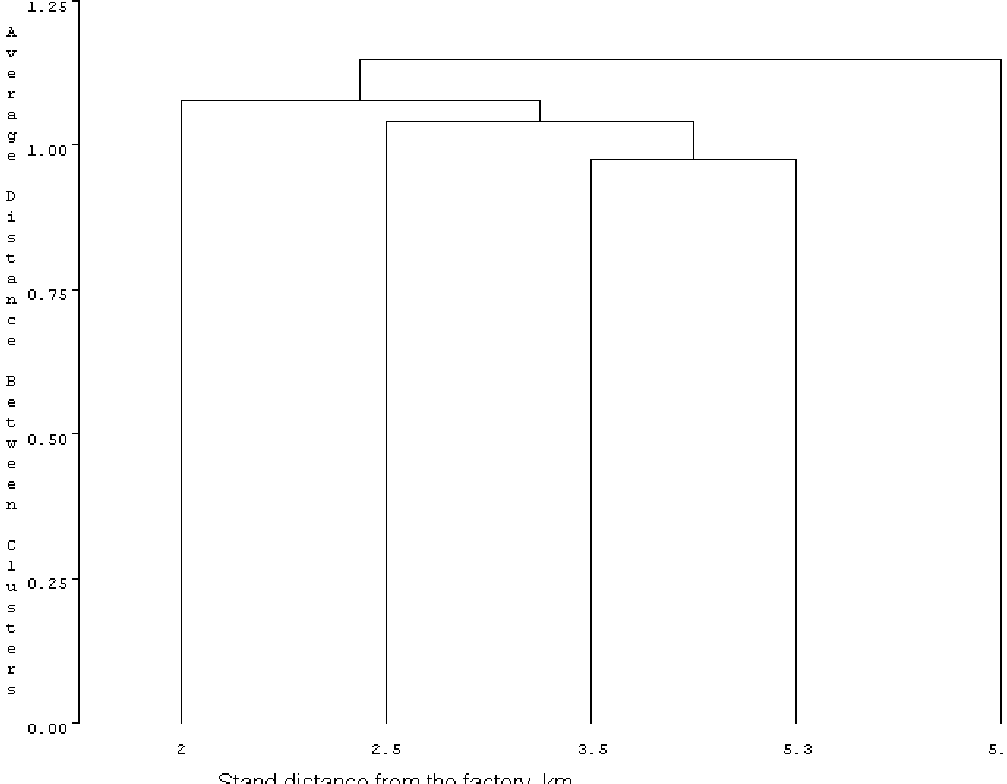
FIGURE 5 . Grouping of Scots pine ( P. sylvestris L.) stands growing at different distances from the oil refinery according to percentage composition (n = 4) of the components (71) of essential oils in current-year needles (July 10,